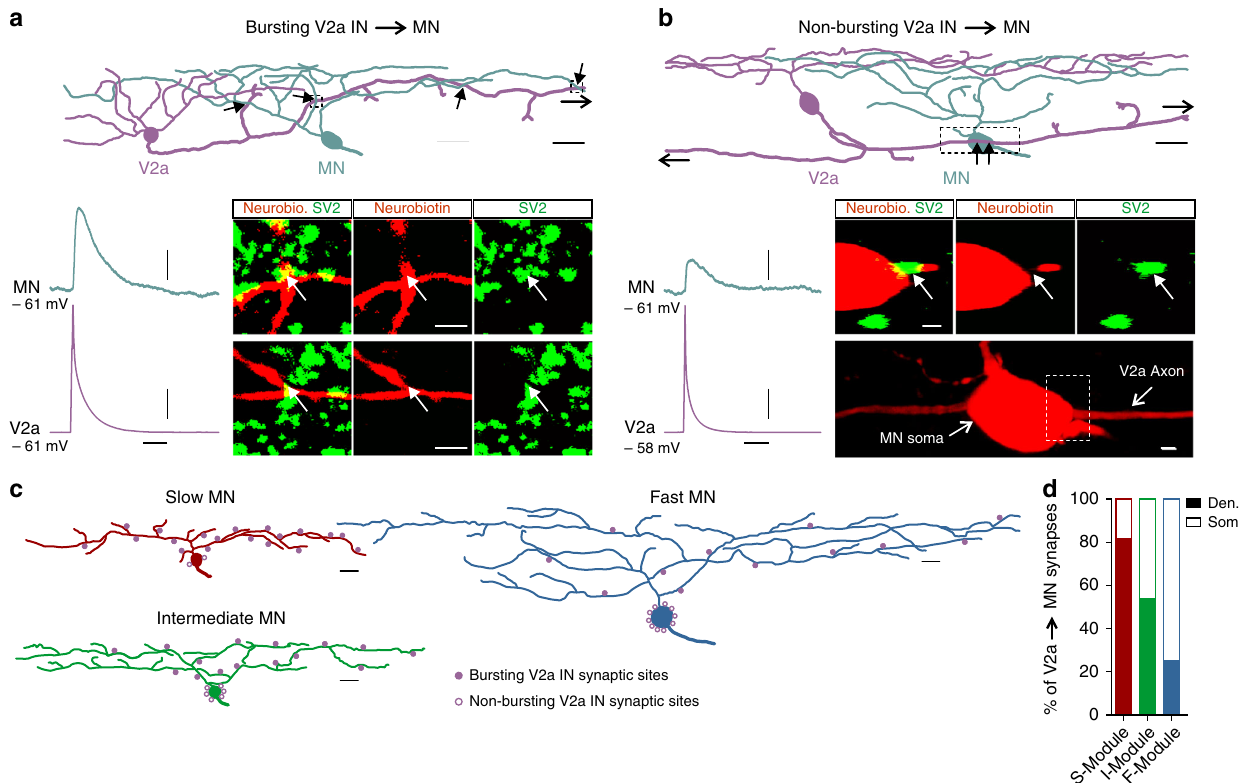
Fig. 3 Distinct axonal projections of the two V2a interneuron types. a The bursting-type V2a interneurons had unidirectional descending axons that target the dendrites of the postsynaptic motoneurons where they produce strong excitatory drive. The fi lled-head black arrows indicate the sites of synaptic contacts between the V2a interneuron axon and the motoneuron dendrites. The open-head arrow re fl ects the fact that the axon project further than shown in this reconstruction. The dashed boxes indicate the regions that are enlarged in the lower panel showing optical sections of the sites of synaptic contacts between the V2a interneuron axon and the motoneuron dendrite that also co-localized the synaptic vesicle protein SV2 (white arrow). b The non-bursting- type V2a interneurons had bi-directional axons projecting in the caudal and rostral directions. They target the soma region of the postsynaptic motoneurons where they produce weak excitatory drive. The fi lled-head black arrows indicate the site of contacts between the axon of the V2a interneuron and motoneuron soma. The open-head arrows re fl ect the fact that the axon project further than shown in this reconstruction both in the rostral and caudal directions. The dashed box corresponds to the enlarged region in the lower panel showing an optical section where the sites of synaptic contacts between the V2a axon and the motoneuron soma as well as the localization of the synaptic vesicle protein SV2 (white arrows). c Reconstructions showing the distribution of synaptic contacts on the dendrites and soma region of the slow, intermediate and fast motoneurons from bursting-type ( fi lled circles) and non-bursting-type (open circles) V2a interneurons. d Percentage of dendritic ( fi lled part of the bar) versus somatic (open part of the bar) synaptic contacts onto motoneurons of the slow, intermediate and fast modules. ( n = 11 slow motoneurons; n = 13 intermediate motoneurons; and n = 11 fast motoneurons). Scale bars, 10 µ m, 1 µ m, 20 ms, 10 mV, 0.2